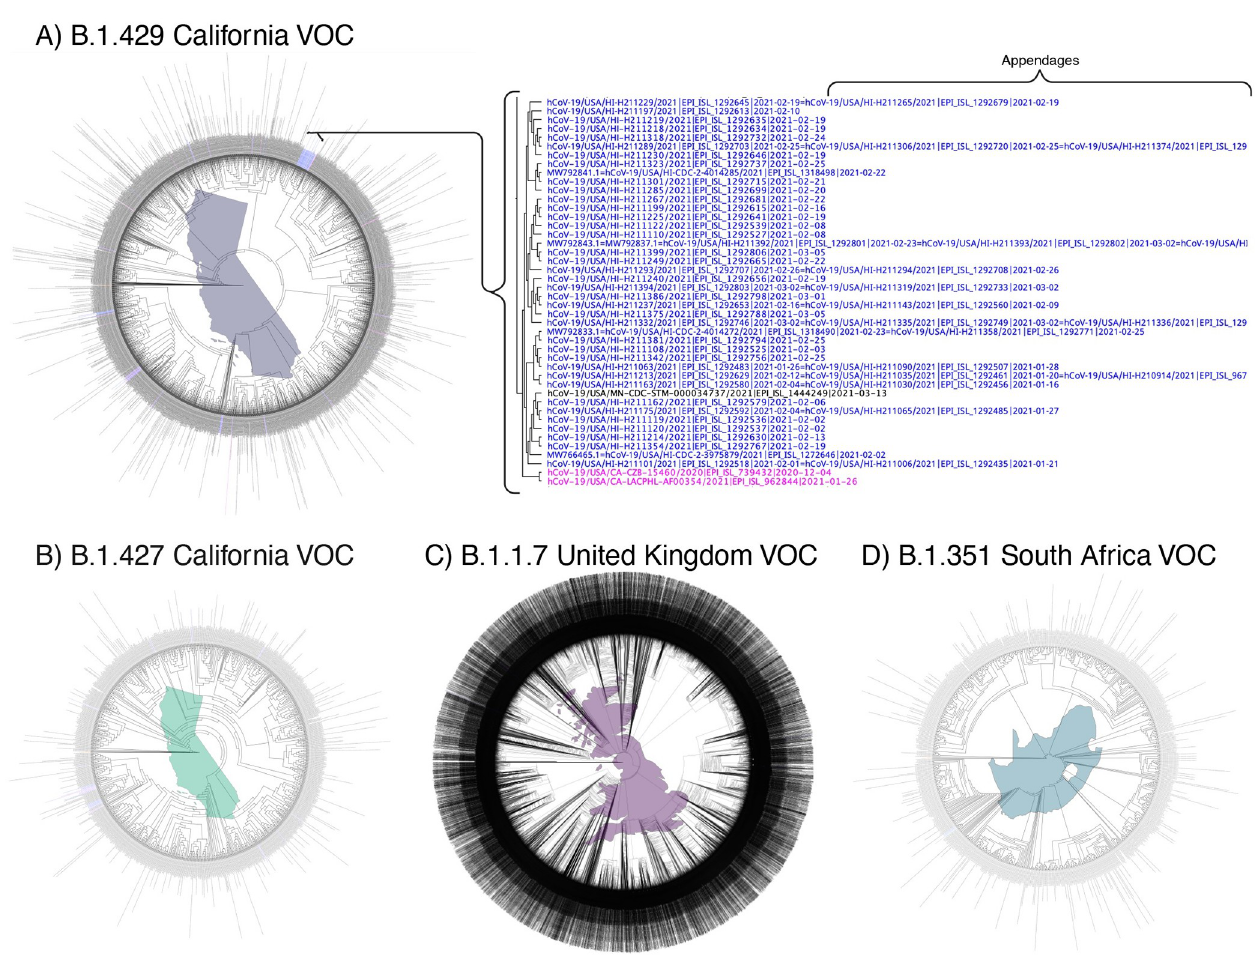
Fig 2. Phylogenetic trees of worldwide SARS-CoV-2 variants of concerns. The phylogenetic trees show the approximately maximum-likelihood trees generated by FastTree in Geneious Prime 2021.0.3 (http://www.geneious.com) and FastTreeMP in the University of Hawai’i MANA High Performance Computing Cluster. The trees were rooted to the SARS-CoV-2 Lineage A reference sequence (EPI_ISL_406801). Clusters and strains from Hawai’i are identified with the colored text (blue), and were evaluated for the most recent common ancestor to define the origin of Hawai’i strains (pink). Text shown in black indicates global variant strains not necessarily directly affiliated with variants found in Hawai’i. Appendage sequences designated by an equal sign (=) indicate identical sequences as generated by the sRNAtoolbox. A) Phylogenetic tree of B.1.429 California variant of concern (VOC) generated using Geneious Prime from 2,809 unambiguous and unique sequences. B) Phylogenetic tree of B.1.427 California VOC generated using Geneious Prime from 1,019 unique and unambiguous sequences. C) Phylogenetic tree of B.1.1.7 United Kingdom VOC generated with FastTreeMP in the MANA HPC using 83,471 unambiguous sequences. D) Phylogenetic tree of B.1.351 South Africa VOC generated in Geneious Prime using 778 unambiguous and unique sequences. Maps generated with the open-source “usmap” and“ggplot2” packages and R under GPL-3 and MIT+ license and are free to use (https://cran.r-project.org/web/ packages/usmap/usmap.pdf)(https://cran.r-project.org/web/packages/ggplot2/index.html). Map editing was done in Adobe Photoshop 22.4.2, and the final figure was created with